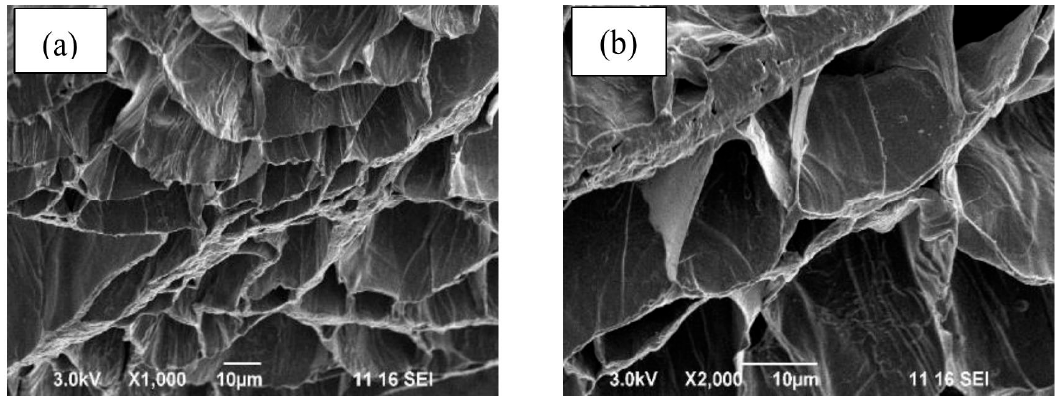
Figure 5. Scanning electron microscope images of PA blend hydrogel (PA5) surface at various magnifications ( a ) ×1000, ( b ) ×2000.